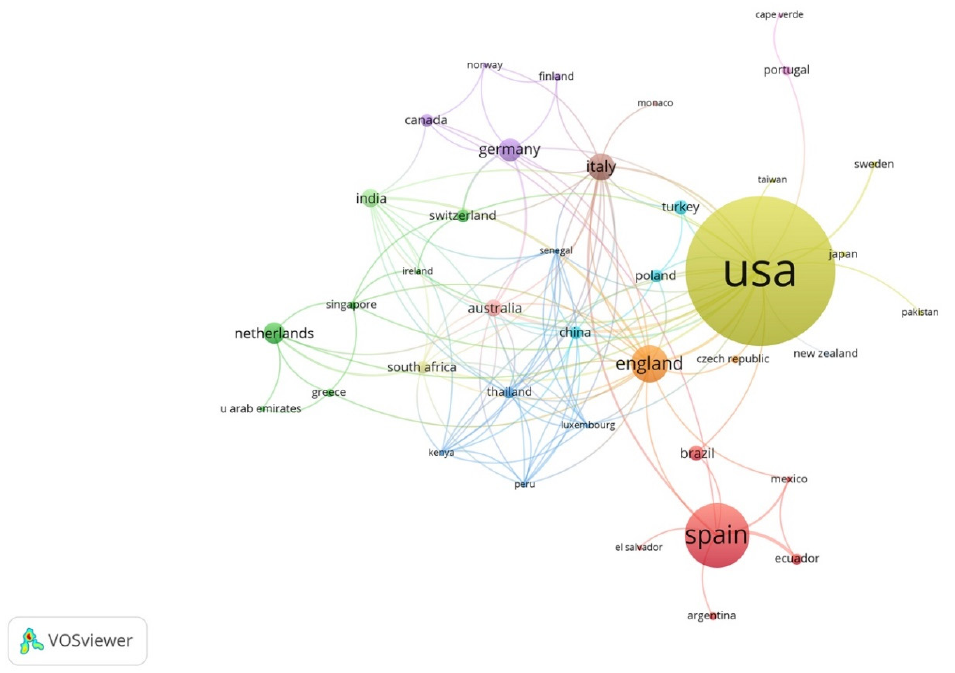
Figure 12. Areas with the greatest influence on scientific production and